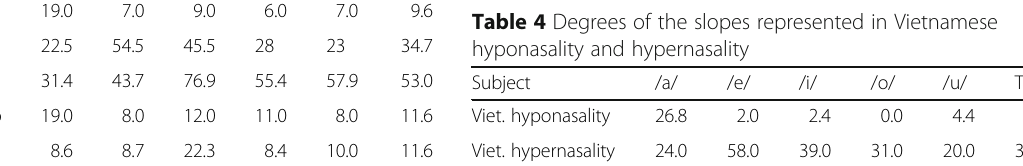
Table 3 Nasalance for Vietnamese and Korean cleft palate children with the control group (%) Subjects